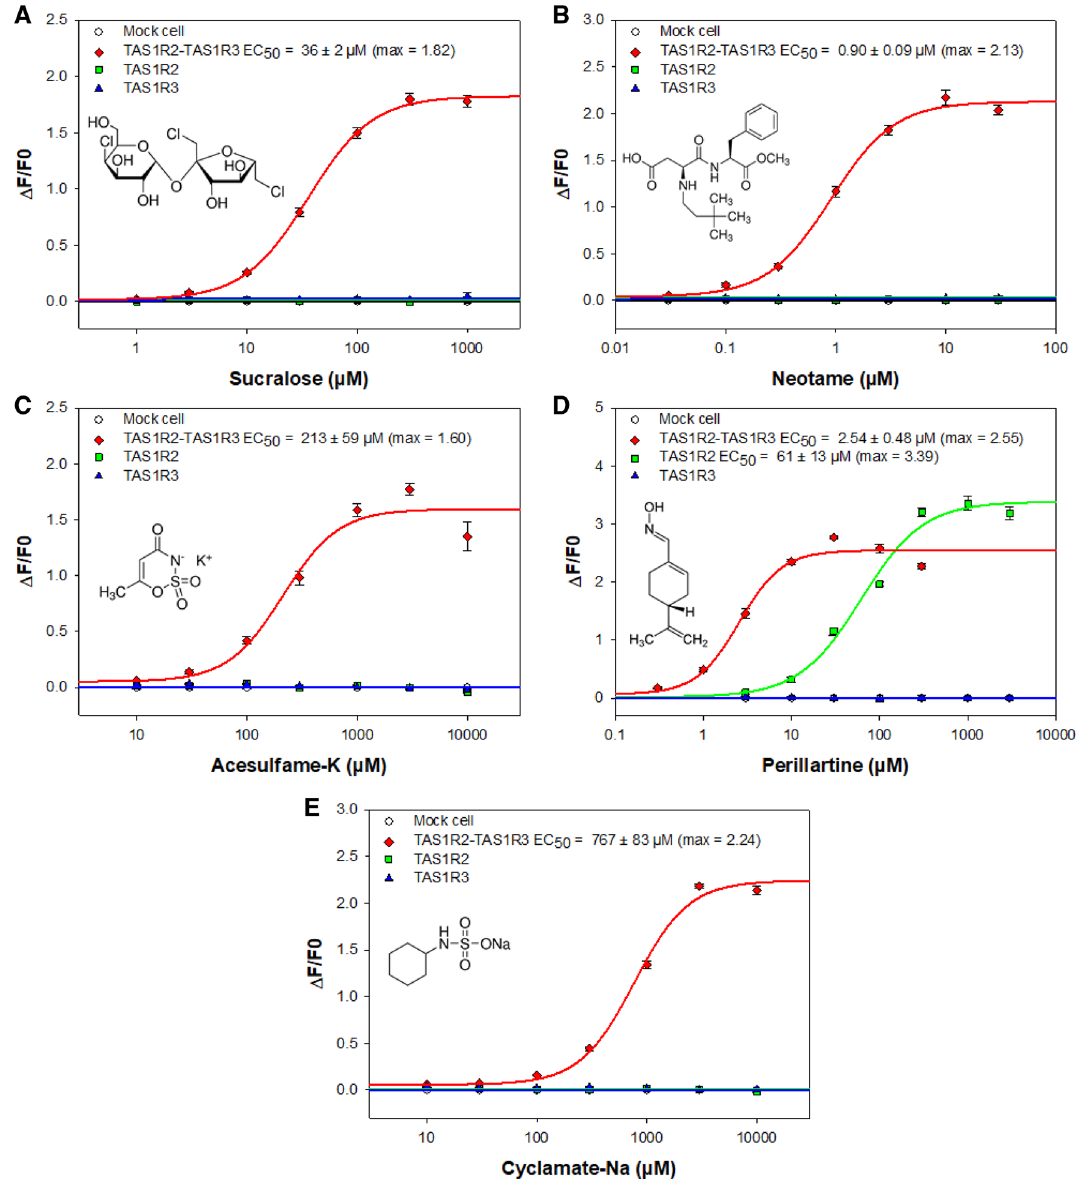
Figure 9. Human TAS1R2/TAS1R3 dose–response curves with different sweeteners. HEK293T-Gα16gust44 cells were transiently transfected with pGP-CMV-GCaMP6S (fluorescent calcium biosensor) combined with pcDNA6-hTAS1R2-FLAG and pcDNA4-hTAS1R3-FLAG (red line), or with pcDNA6-hTAS1R2-FLAG alone (green line) or pcDNA4-hTAS1R3-FLAG alone (blue line) or empty expression vector alone (mock cell) for the control (white circles, solid black line). Sweet taste stimuli were automatically applied to the transfected cells, and fluorescence changes were monitored using a FlexStation 3. The logarithmically scaled x-axis indicates the sweetener concentration in µM, and the y-axis shows the variation in fluorescence upon agonist application. Sucralose ( A ), neotame ( B ), acesulfame-K ( C ), perillartine ( D ), and cyclamate-Na ( E ). Data represent mean ± sem of eighteen wells from three independent